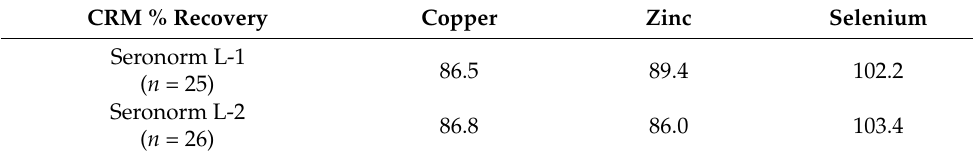
Table A2. Average recovery (%) for three elements compared to accredited